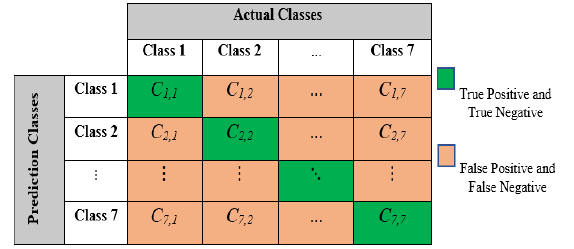
Figure 6 . Confusion